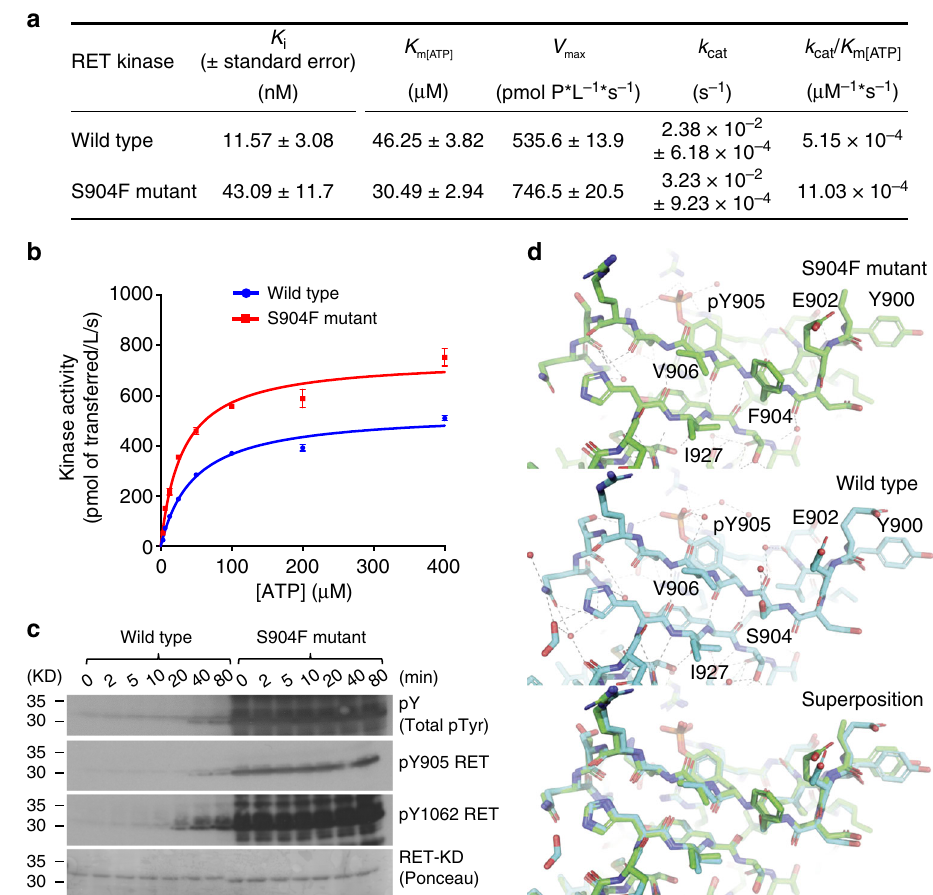
Fig. 3 Kinetic and structural properties of the RET-S904F mutant. a Enzyme kinetics parameters of wild type and S904F mutant RET KD proteins. The kinase assay was performed in triplicate at 25 °C for different incubation times (0, 10, 20, 30, 40, and 50 min) using puri fi ed RET KDs, increasing concentrations of ATP (3.125 – 400 nM), and serially diluted vandetanib. The assay was initiated by addition of 32 P-ATP, and the reaction mixture was incubated at 30 °C. These experiments were performed independently three times. The data were analyzed using GraphPad Prism version 6.0 to calculate kinetic parameters, K i , and IC 50 values. b Saturation curve graphed by Michaelis – Menten equation. The graph with standard deviations (shown as error bars) was generated using GraphPad Prism. c Western blotting showing the autophosphorylation time course in the wild type and S904F mutant RET KDs. Phosphorylation of the recombinant puri fi ed RET KDs treated with ATP (5 mM) and MgCl 2 (10 mM) for 0 – 80 min was detected with the indicated antibodies. d Comparison of S904F and wild-type RET structures. (Upper) Detail of side chain contacts close to the F904 mutation site of mutant RET kinase domain (PDB code 6FEK). Selected sidechains are labeled. Bound waters are shown as red spheres and hydrogen-bonds drawn in gray as de fi ned by Pymol Molecular Graphics System (Schrödinger, LLC, New York, NY). (Middle) Detail of side chain contacts close to the S904 of wild-type RET kinase domain (PDB code 2IVT), colored as per panel (upper). (Lower) Overlay of the RET core kinase domain wild type and S904F mutant structures